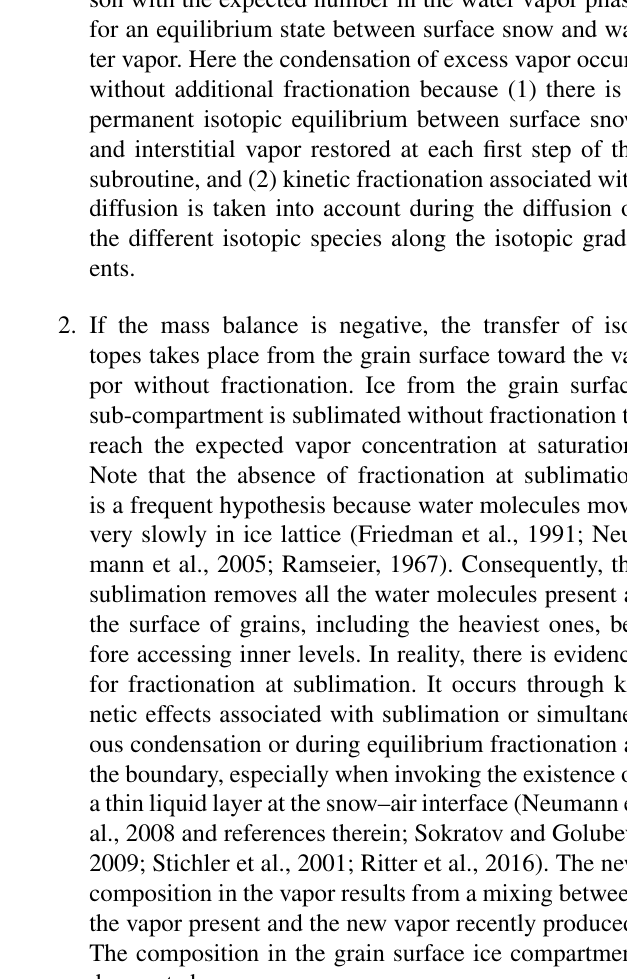
adjacent layers, the total flux of vapor is null. But